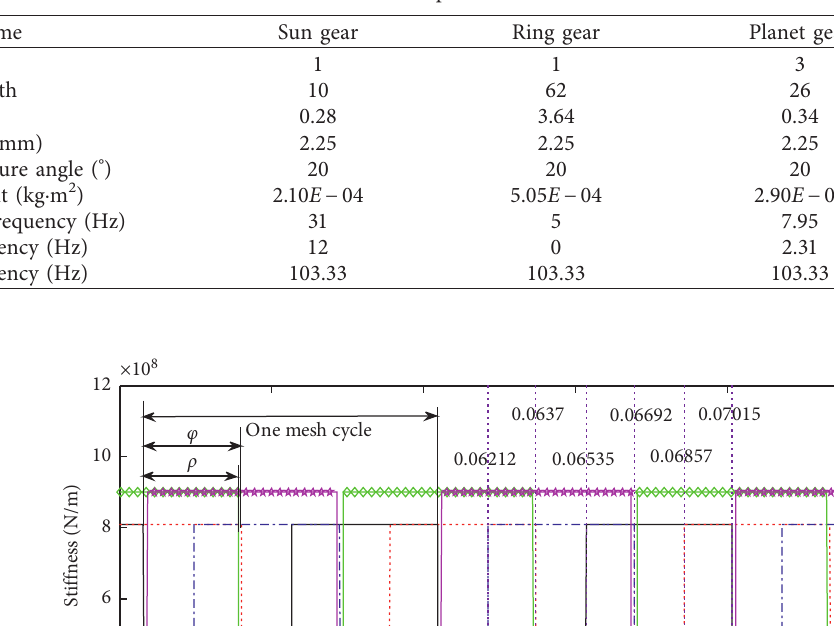
Table 1: Basic parameters of the